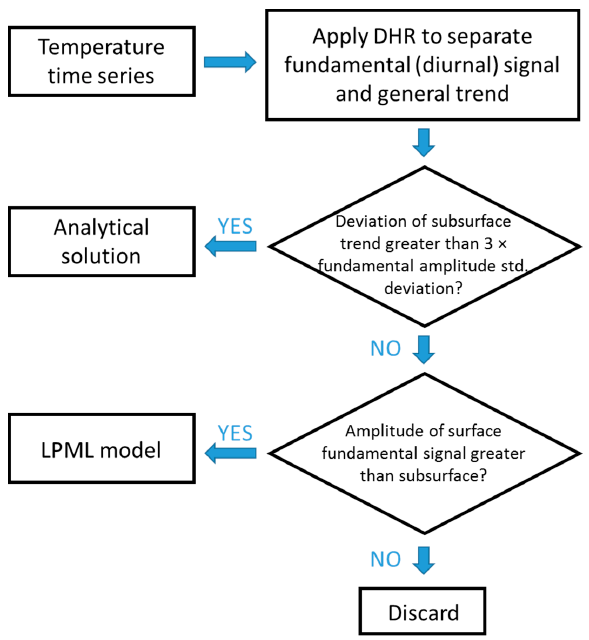
Figure 5. The framework employed to estimate hyporheic fluxes.